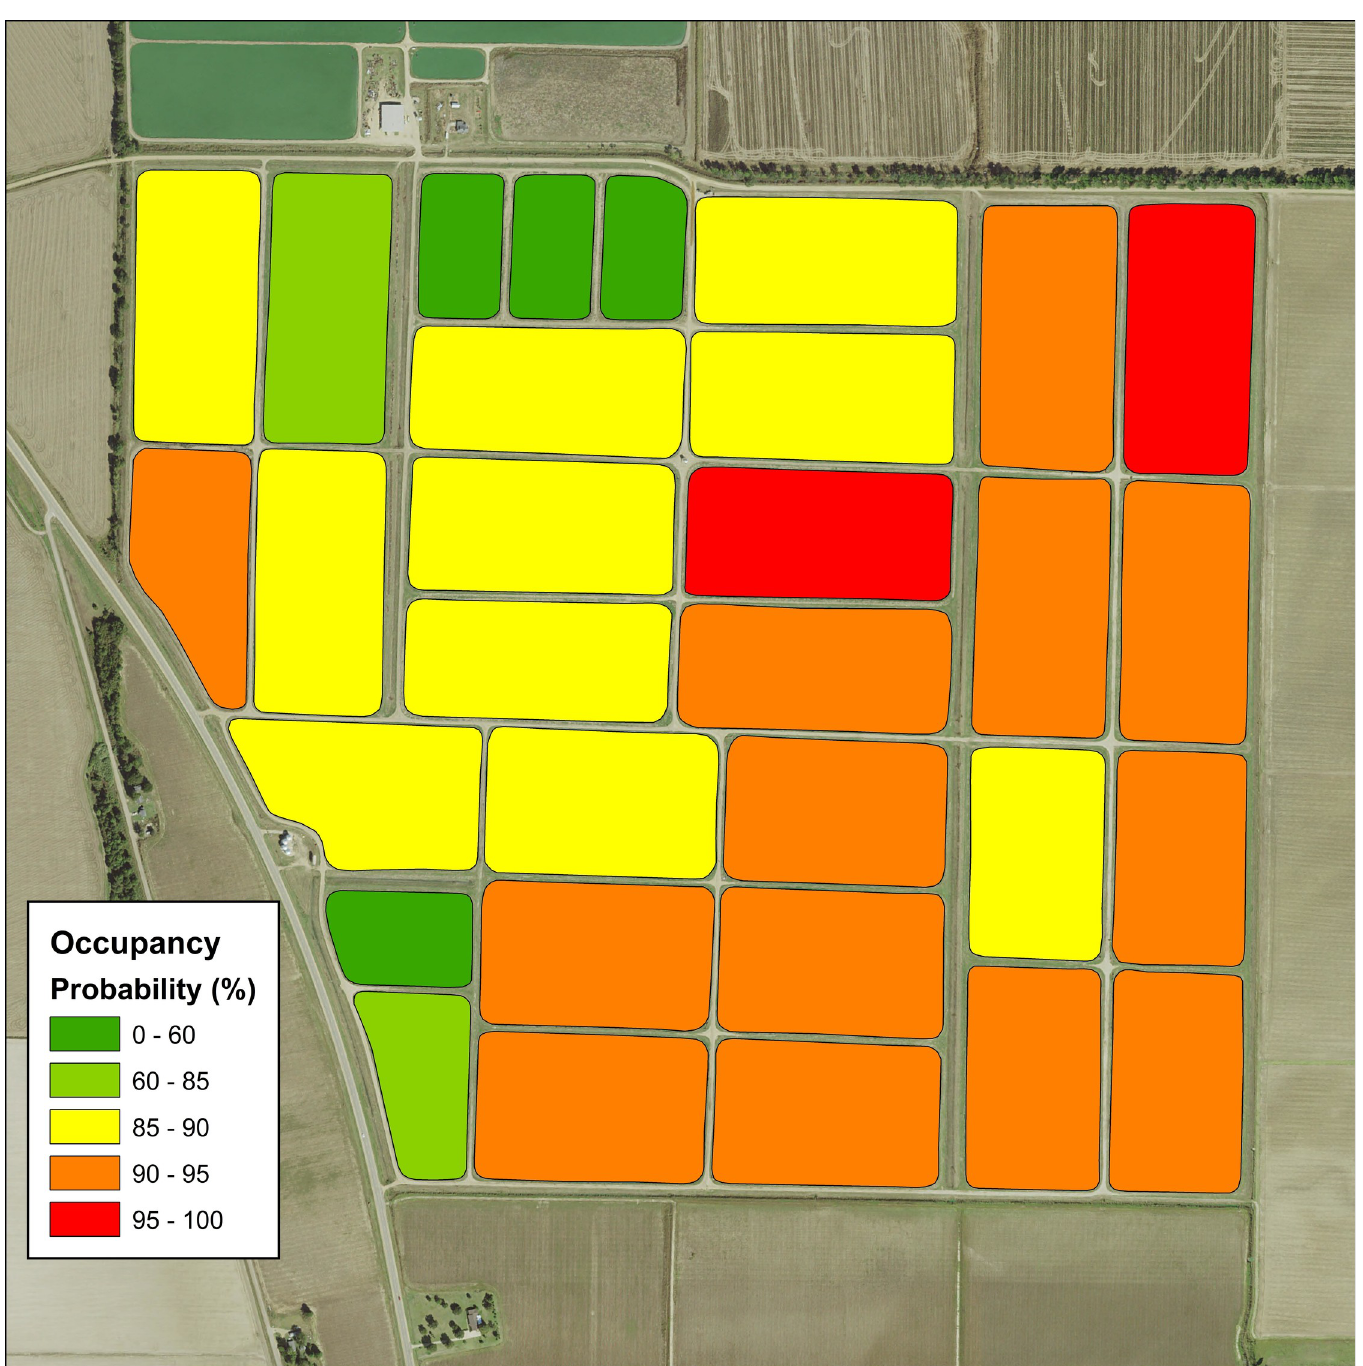
Fig 7. Occupancy probability of cormorants on a selected group of catfish ponds within the Mississippi Delta. Estimates were obtained by incorporating actual data of each pond into an occupancy model (Table 5). Information such as this has the potential to increase bird harassment efficiency and to inform future stocking decisions.